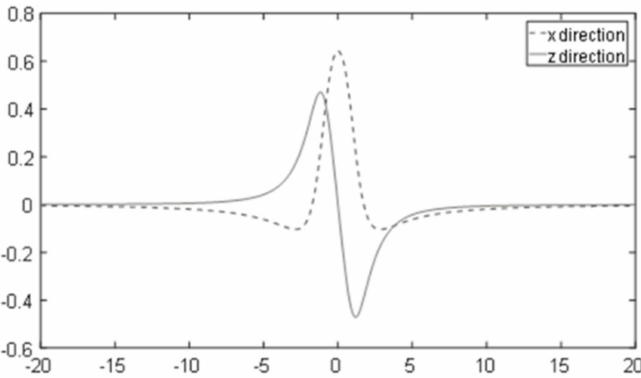
Figure 4. Magnetic field distribution in the x and z